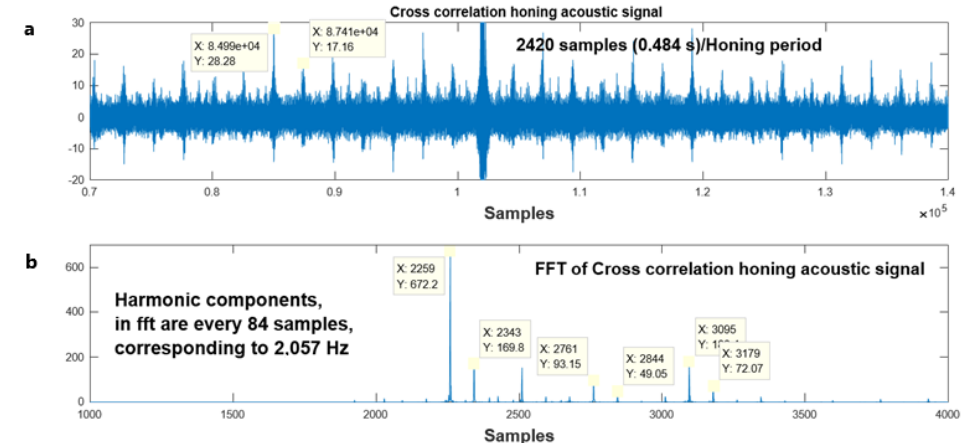
Figure 6. Signals of experiment 2: ( a ) Auto cross-correlation of the signal and ( b ) Fast Fourier transform (FFT) of the auto-cross correlation.